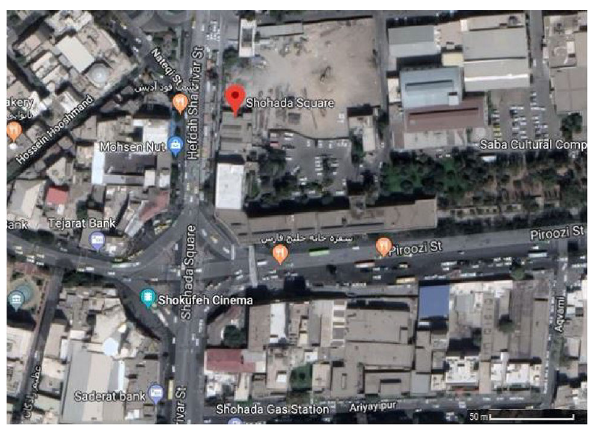
Fig. 1 Shohada Square